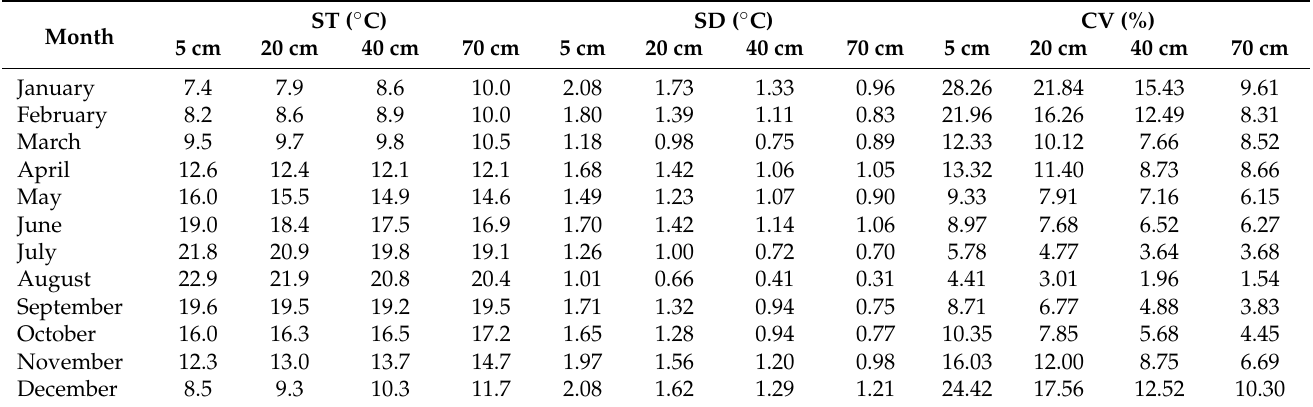
Table 3. Soil temperature (ST) variations with depth for the period